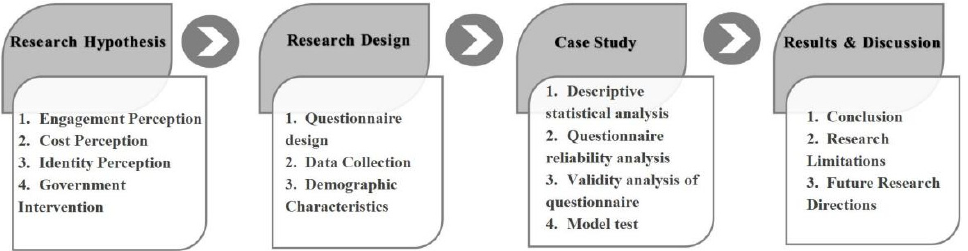
Figure 1. Research Path and